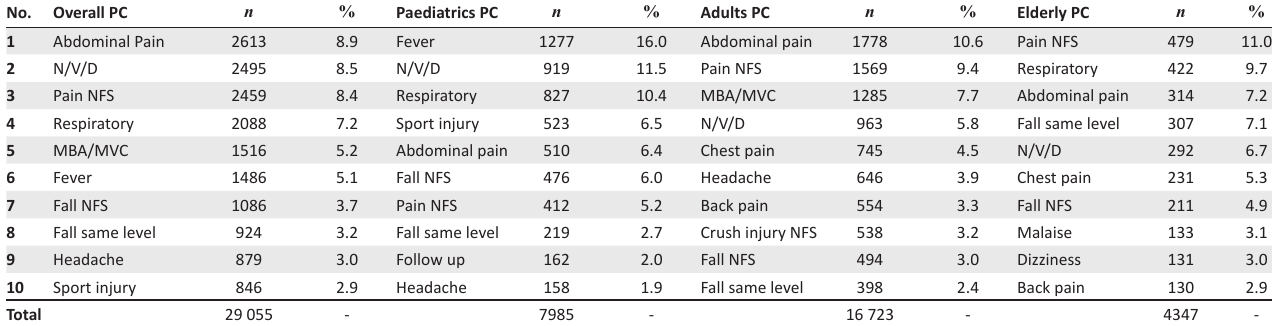
TABLE 3: Top 10 presenting complaints in a private emergency centre in Pretoria (South Africa) in 2018. No. Overall PC